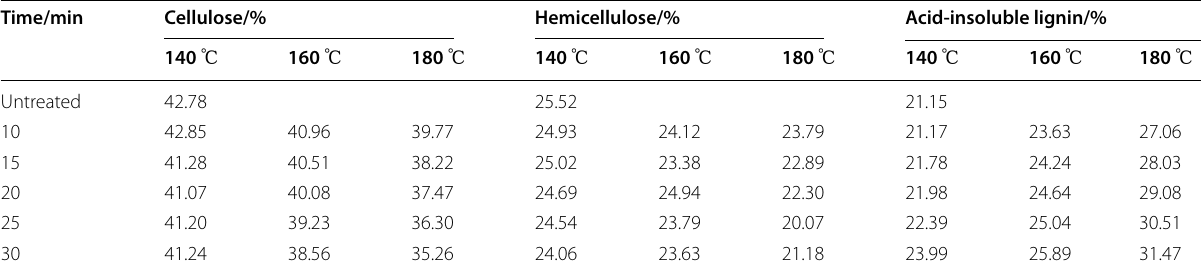
relative content of cellulose and hemicellulose showed a general downward trend, while the relative content of acid-insoluble lignin shows an upward trend when treated at 160 °C. This finding is in agreement with the results reported by Zhao et al. [19] and Lee et al. [12].